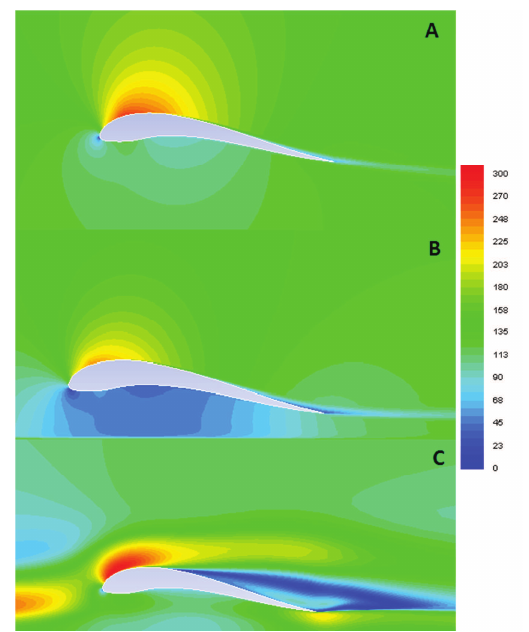
Fig. 7. Air velocity distribution: A – free stream flight; B – WIG effect flight; C – WIG with exhaust gasses redirection under airfoil [m/s]